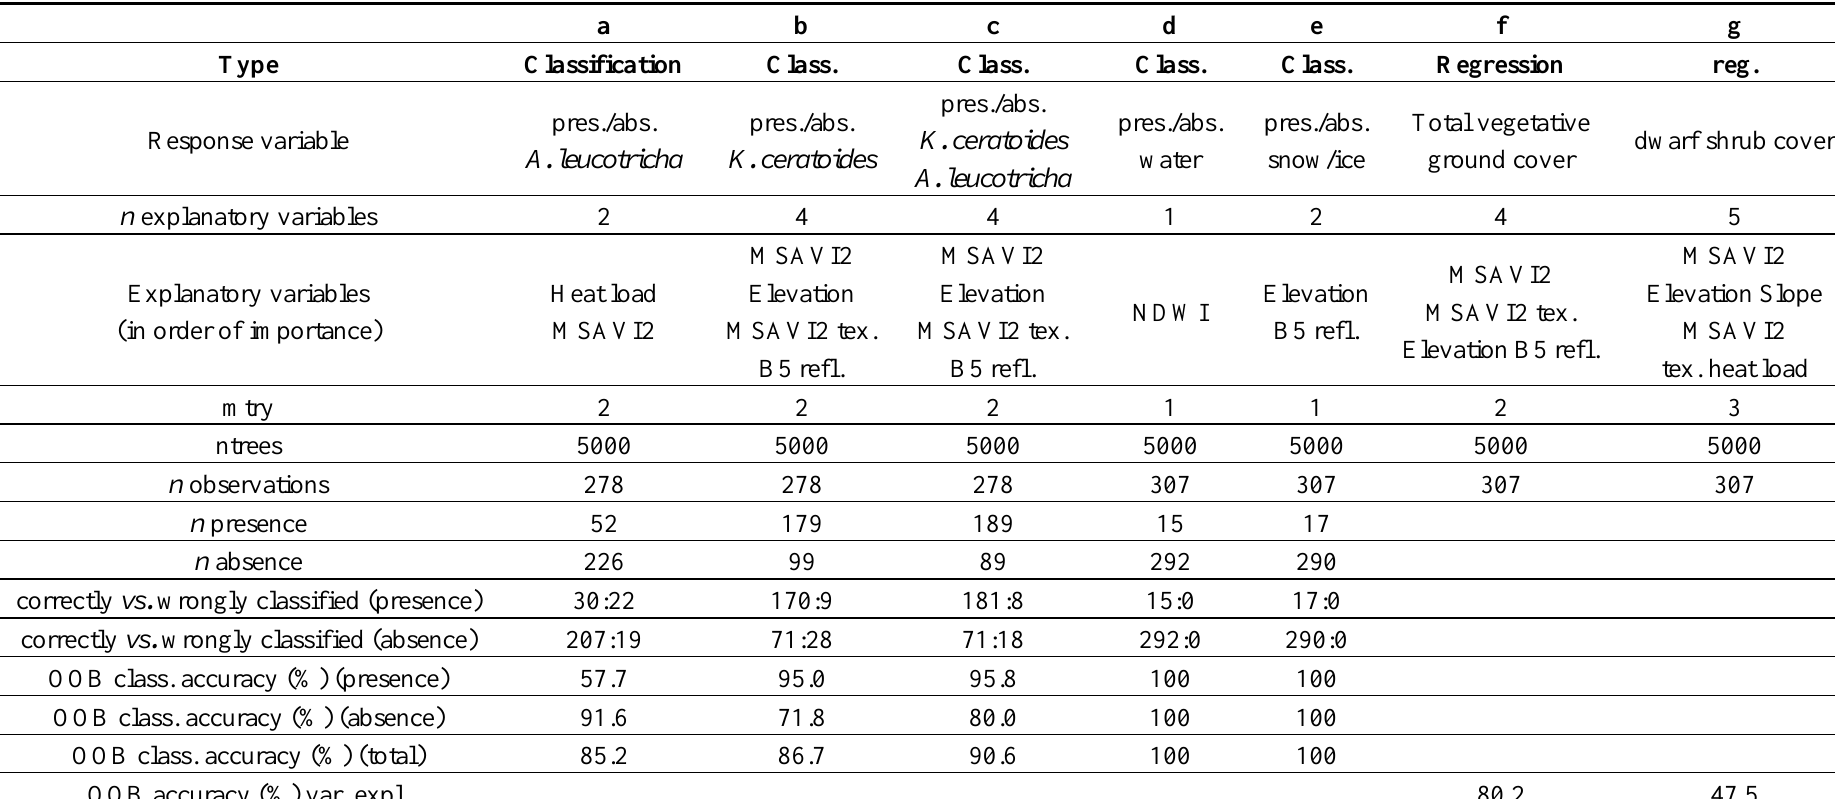
Table 2. Description and evaluation of the calculated models (mtry: number of variables randomly sampled as candidates at each split; ntrees: number of trees grown for the model; OOB: